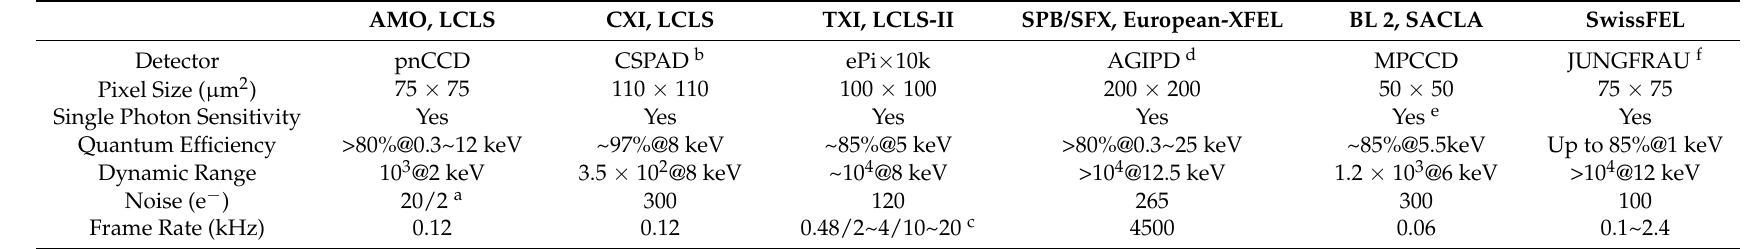
Table 1. Main characteristics of detectors used for LCLS, LCLS-II, European-XFEL and